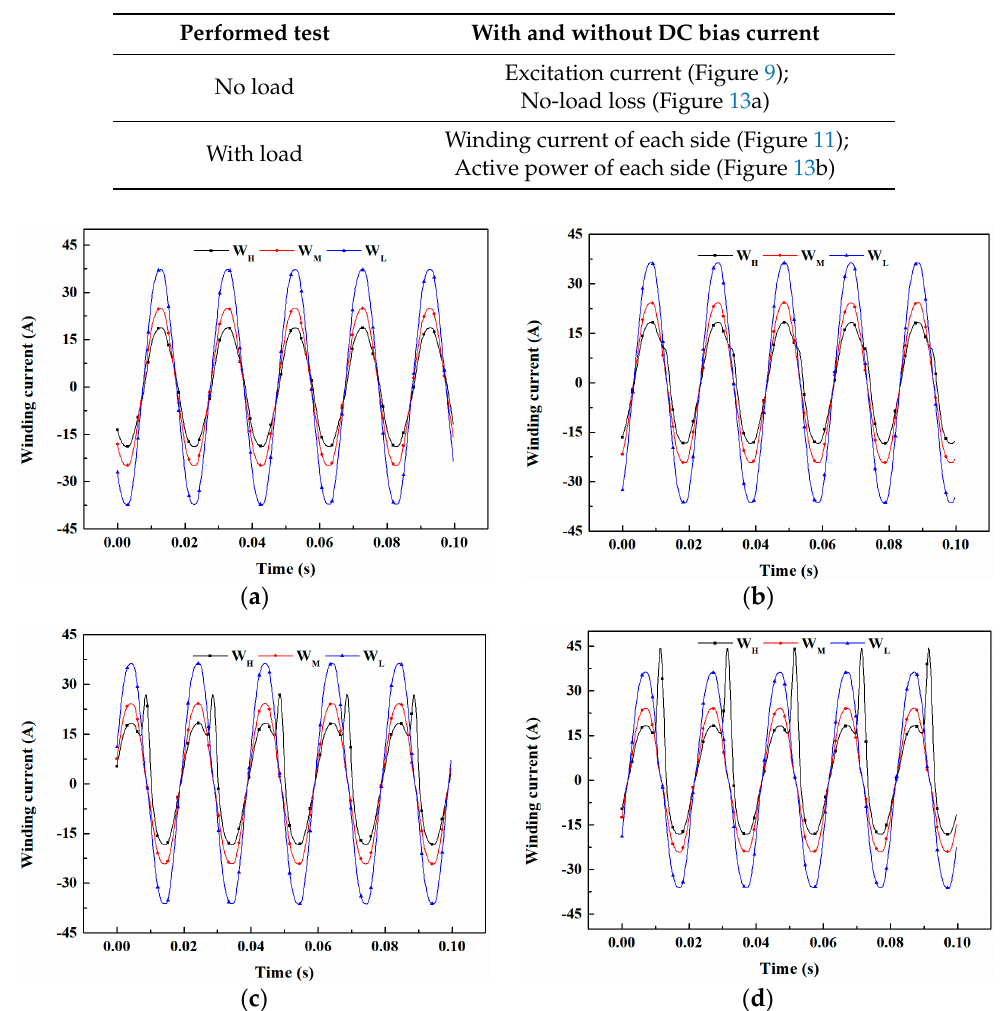
Figure 11. Winding current waveforms with load under various DC bias current. ( a ) without DC bias current. ( b ) under 1 A DC bias current. ( c ) under 3 A DC bias current. ( d ) under 5 A DC bias current.